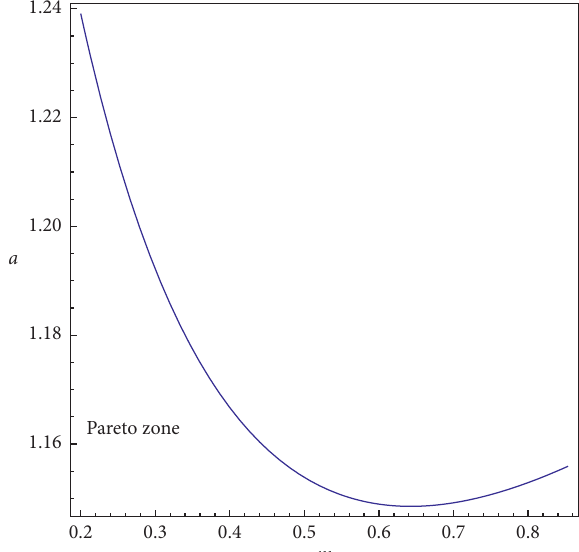
Figure 4: Pareto zone for full coordination under the centralized rebate with manufacturer’s offering r sTSC ∗ M